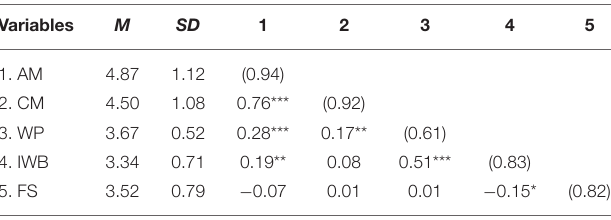
TABLE 3 | Hierarchical regression analyses to assess the effect of financial stress (FS) in affecting the relationships between autonomous motivation (AM), work performance (WP), and innovative work behaviour (IWB).